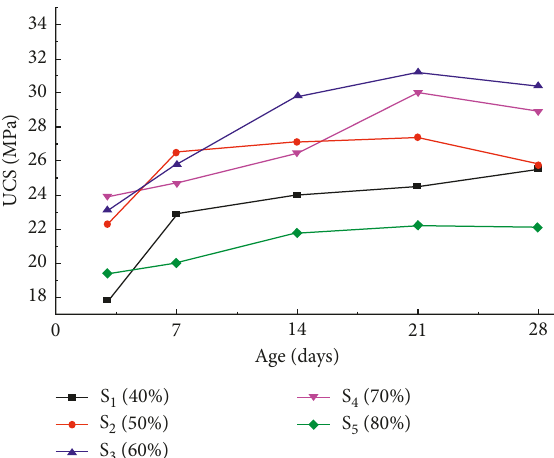
Figure 5: Compressive strength of different humidity.